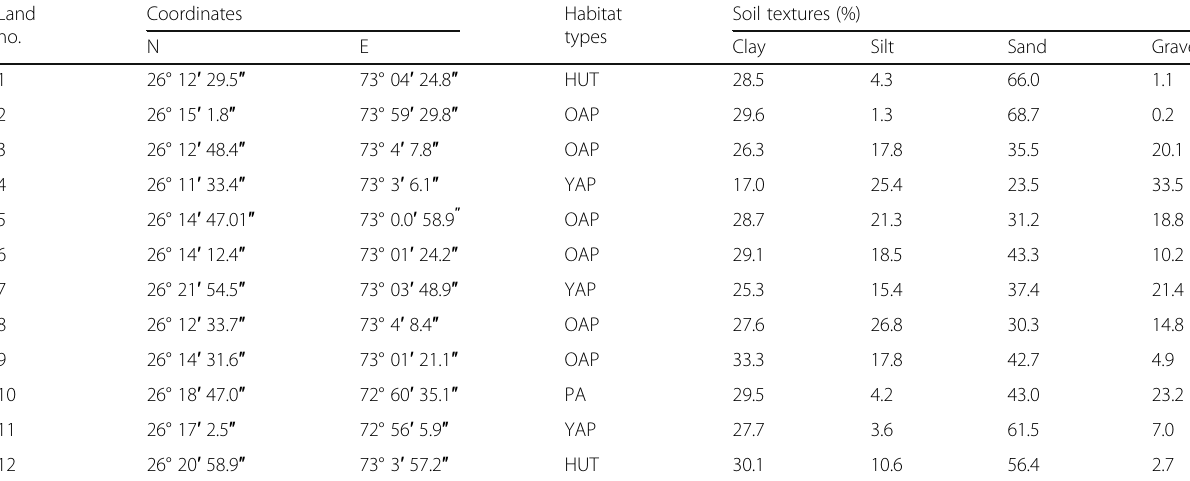
Table 1 GPS locations, habitat types, and other attributes of sampling lands at Jodhpur Land no.